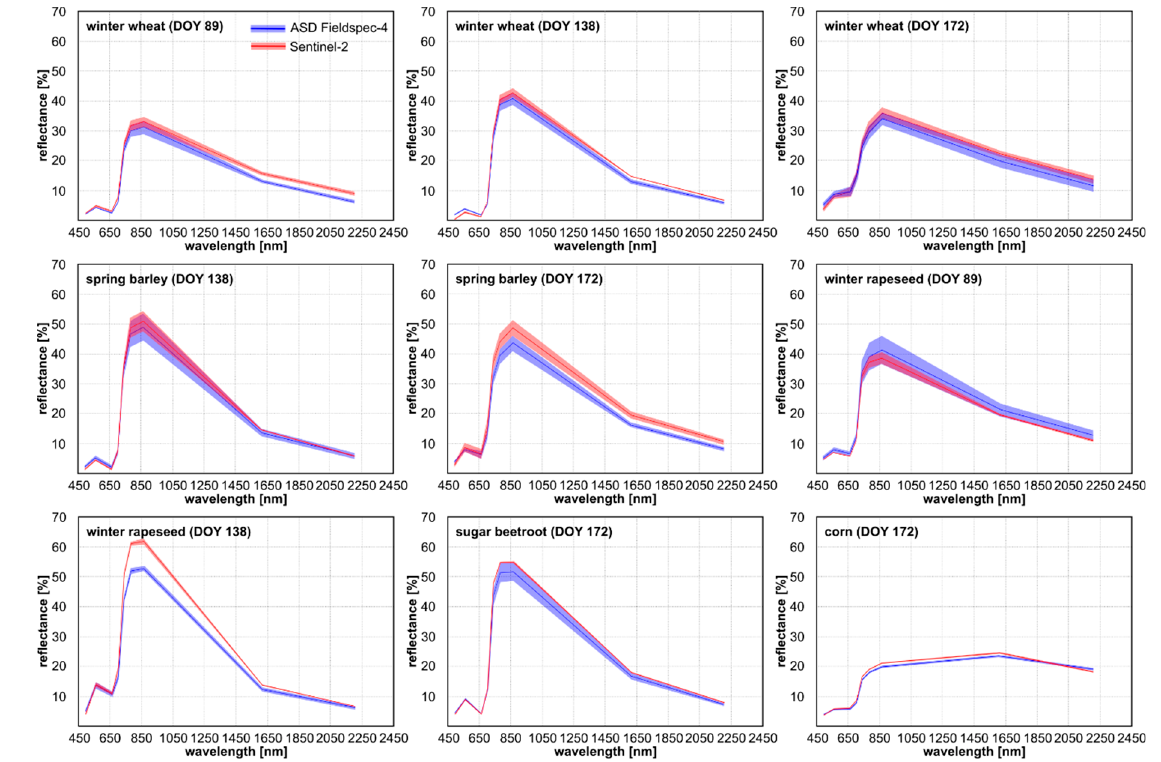
Figure A2. Sentinel-2 and in situ measured spectra for the different development stages of crops of interest.